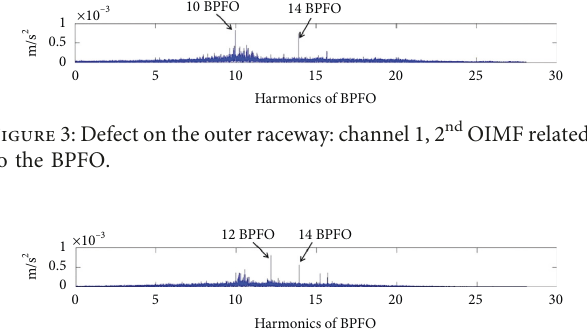
Figure 4: Defect on the outer raceway: channel 2, 2 nd OIMF related to the BPFO.